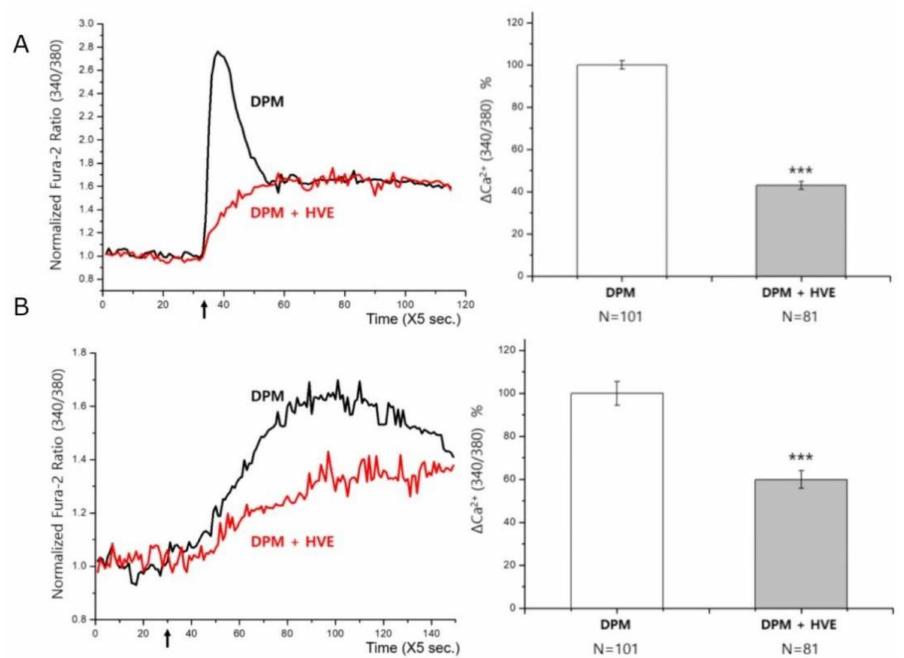
Figure 1. [Ca 2+ ] i of HBT-SM ( A ) and HaCaT ( B ) cells were monitored. Both cells showed previously reported Ca 2+ influx by DPM addition at the indicated time (arrows, 25 µ g/mL in the media), which HVE (2% in the media) successfully inhibited (red curves). Ns indicate the number of cells that we analyzed for the quantification. After normalization, the difference between DPM only and DPM+HVE was analyzed using a Student’s t -test. *** p <